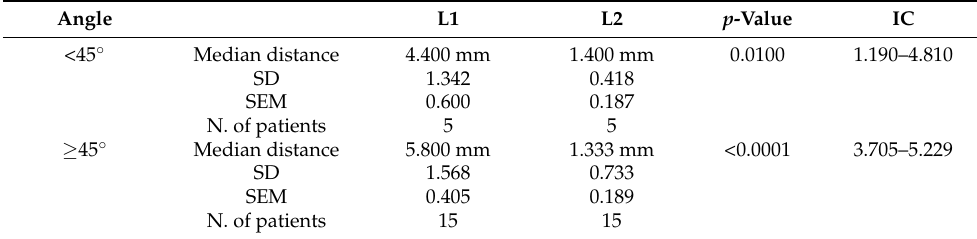
Table 6. Analysis of accuracy of measurement over two patient